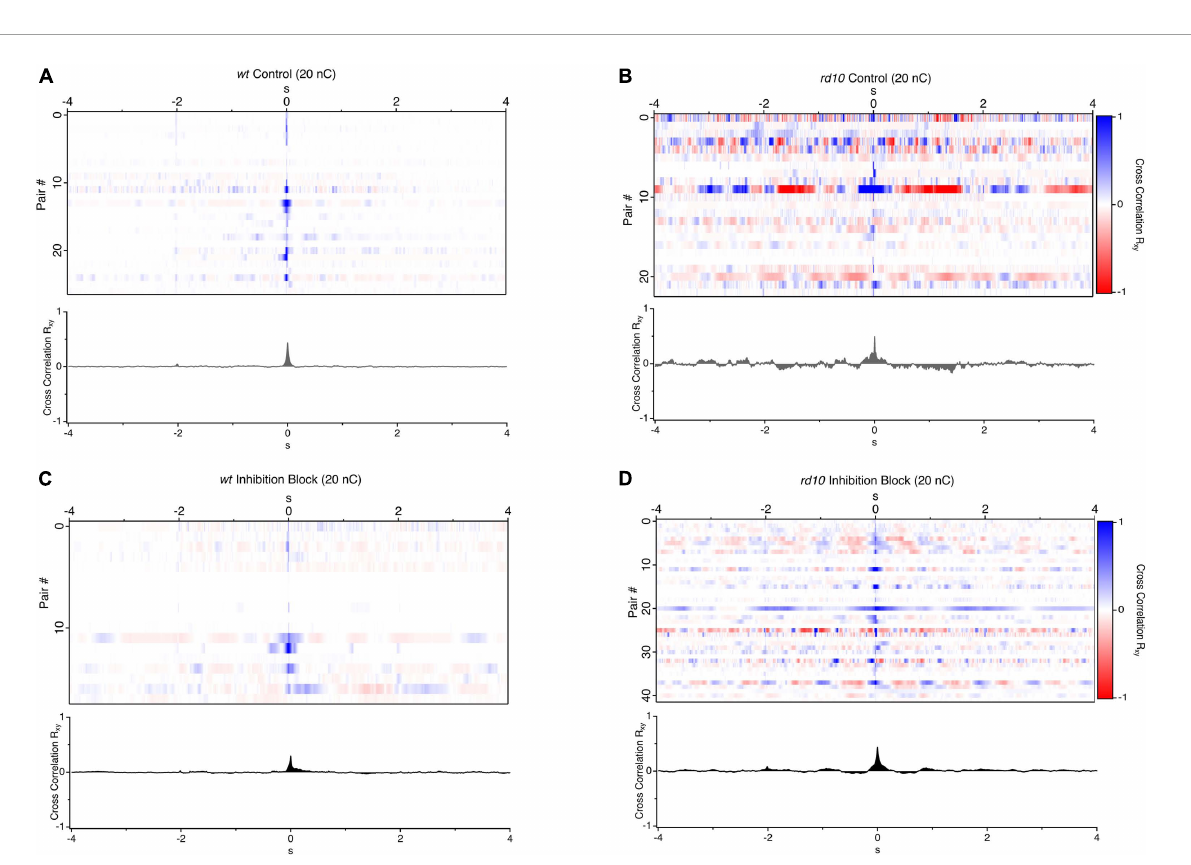
FIGURE2 Cross correlations of evoked and spontaneous activity between RGC pairs. (A) Heatmaps of spike rate cross-correlations between pairs of RGCs where each line is a pairwise cross-correlation for wt ( n = 27), and (B) rd10 RGCs ( n = 23) in control conditions and (C,D) during application of inhibitory antagonists (5 µ M SR-95531, 50 µ M TPMPA, and 5 µ M strychnine), wt ( n = 18) and rd10 ( n = 41). A 20 nC, 1 ms biphasic stimulus was used. Traces below each heatmap are the average cross-correlation for all RGC pairs in each